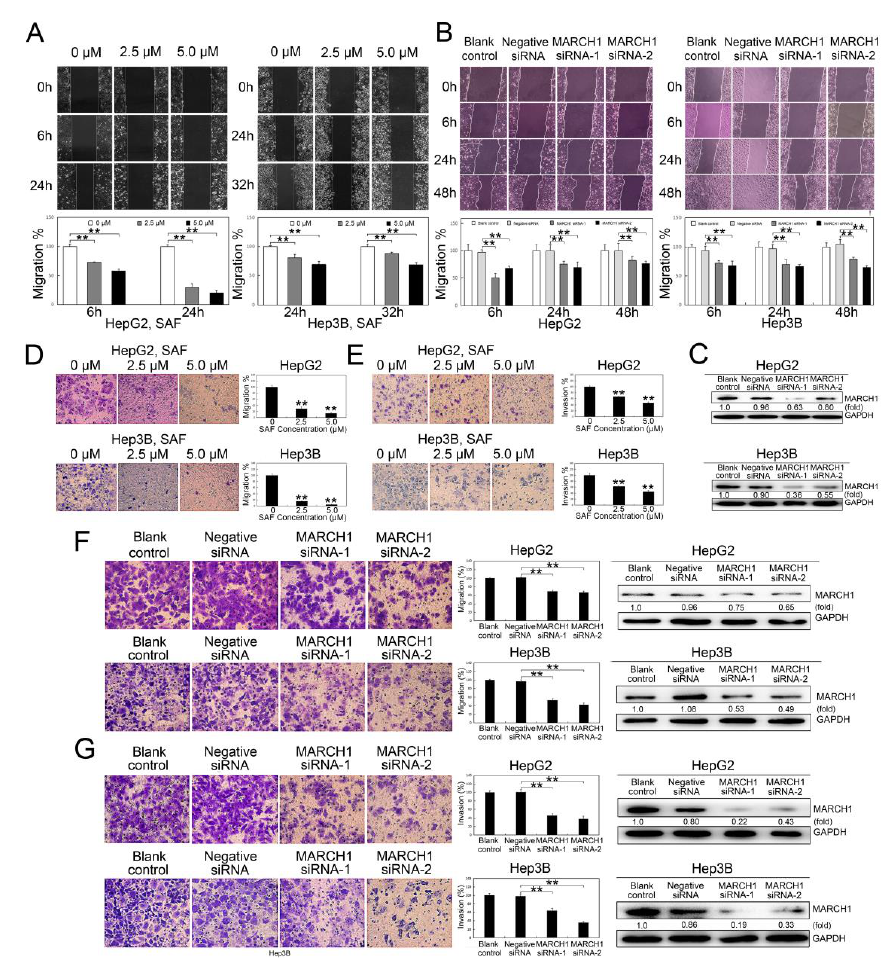
Figure 3. Effect of SAF on HCC cell migration and invasion. ( A ) Wound healing assay for HepG2 and Hep3B cells after SAF treatment, 0 µ M as control. ( B ) Wound healing assay in HepG2 and Hep3B cells with MARCH1 interference, negative siRNA as control. ( C ) Knock down of MARCH1 protein with siRNAs in HepG2 and Hep3B cells. ( D ) Transwell migration assay for HepG2 and Hep3B cells after SAF therapy, 0 µ M as control. ( E ) Transwell invasion assay for HepG2 and Hep3B cells in response to SAF, 0 µ M as control. ( F ) In vitro Transwell migration of HepG2 and Hep3B cells transfected with